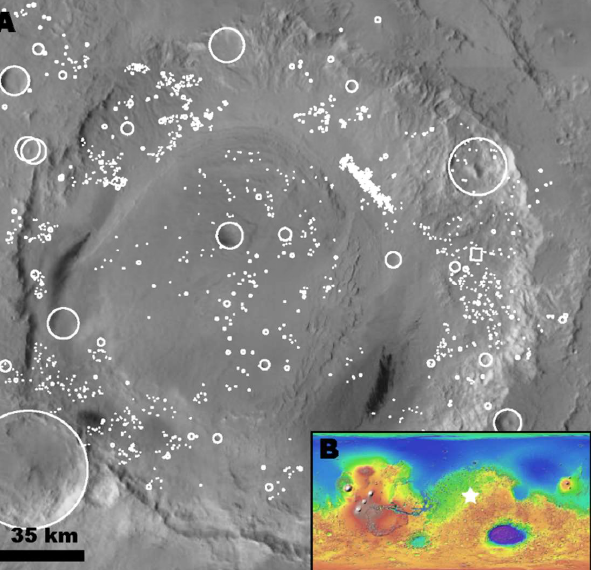
Figure 5. Study area on Mars. ( A ) Henry crater as seen in a CTX image mosaic. The study area is approximately the extent shown. Craters measured in the Henry crater study area are outlined in white. ( B ) A Mars Orbiter Laser Altimeter topographic map of Mars with the location of the Henry crater (star).